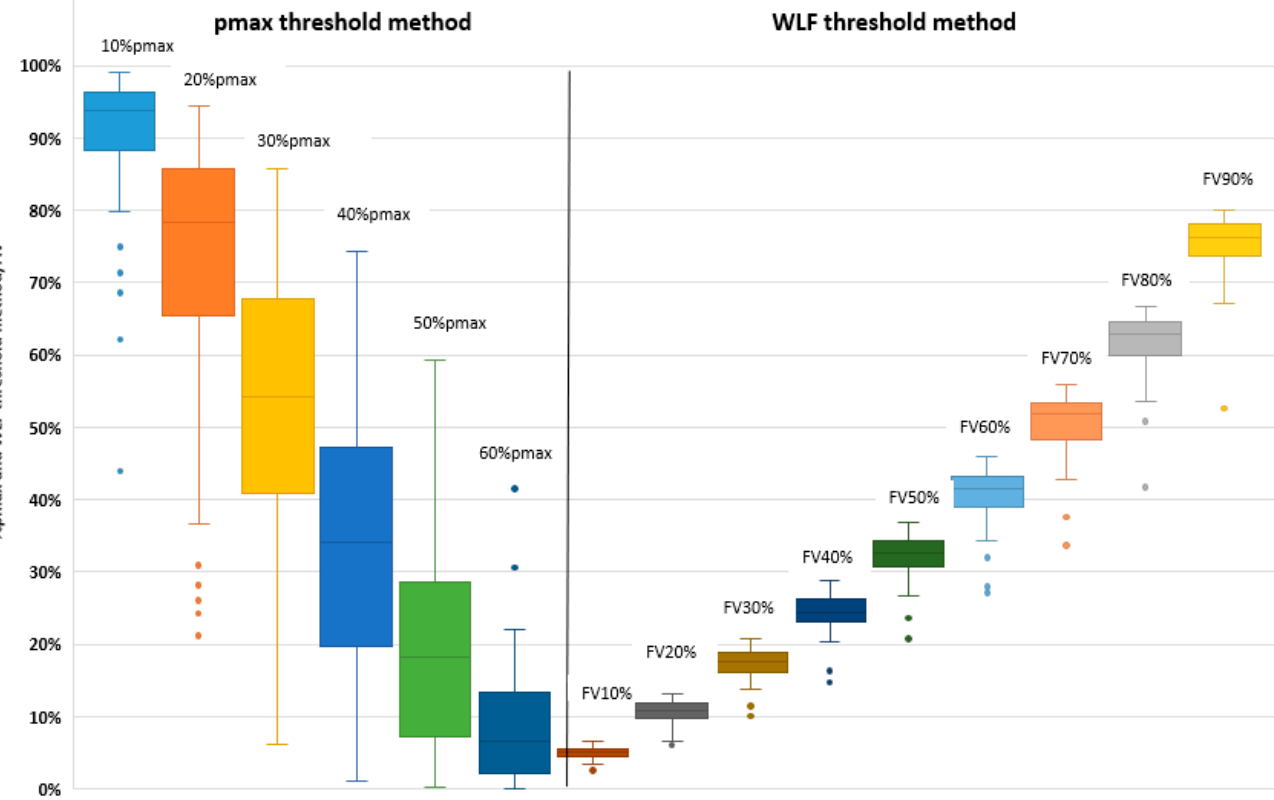
Figure 1. Functional volumes (FV) relative to AV using pmax threshold method (left) and WLF threshold method (right). Table 2. Lung functional volumes expressed in % of the AV and in % of the total activity in the AV for the pmax threshold method. Lung functional volumes expressed in % of the AV and the corresponding pmax threshold for each FV% for the WLF threshold